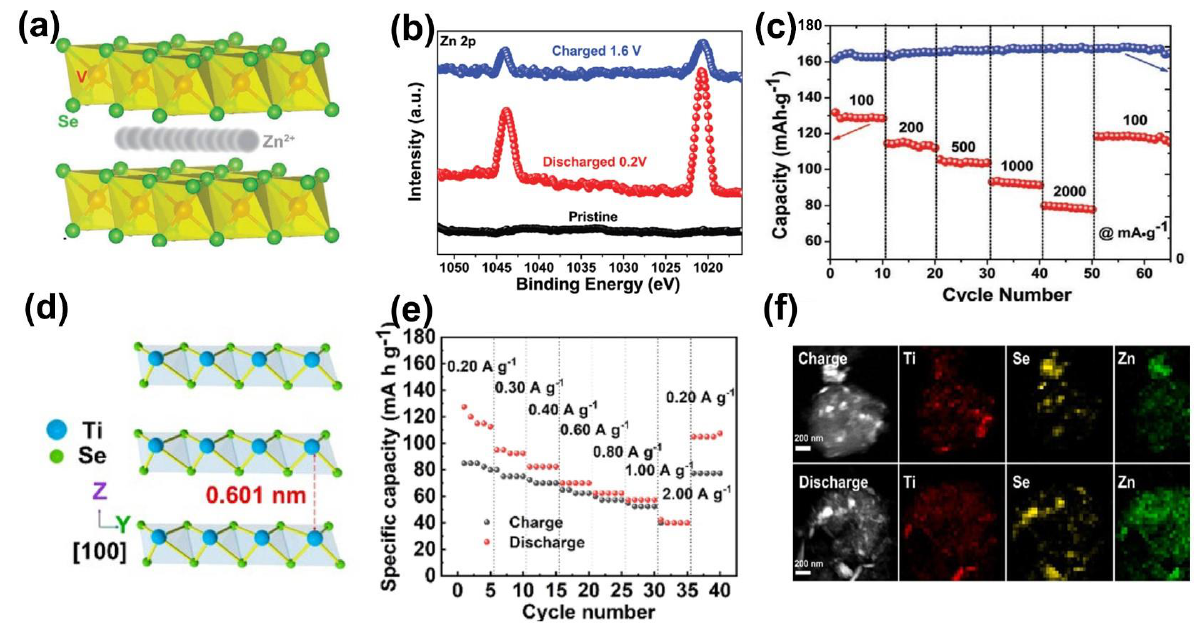
Figure 5. Metallic 1T TMDs for high − performance ZIBs . ( a ) Atomic structure of VSe 2 . ( b ) Ex situ high − resolution XPS of the Zn 2p of the cathode at different states. ( c ) Rate performance of VSe 2 electrodes from 0.10 to 2.00 A·g − 1 . Reprinted with permission from Ref. [44]. Copyright 2020, Wiley- VCH GmbH, Weinheim. ( d ) Schematic atomic structure of TiSe 2 . ( e ) Rate capability at various current densities. ( f ) Elemental distribution characterization of discharged/charged TiSe 2 . Reprinted with permission from Ref. [16]. Copyright 2021, Elsevier.